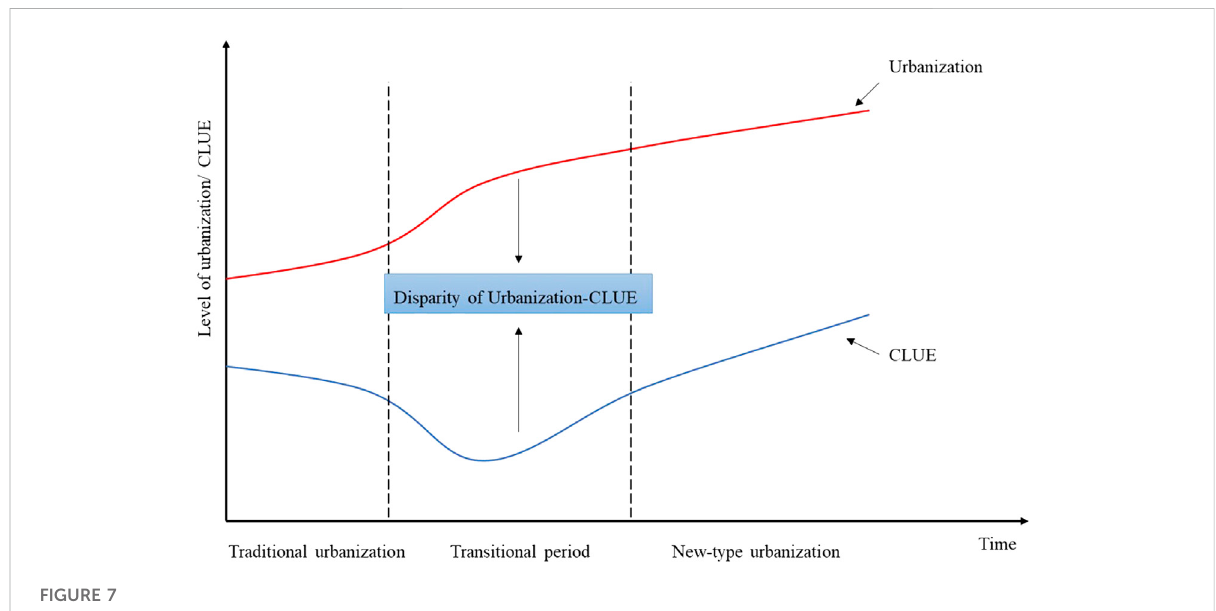
FIGURE 7 Evolution of the level of urbanization and